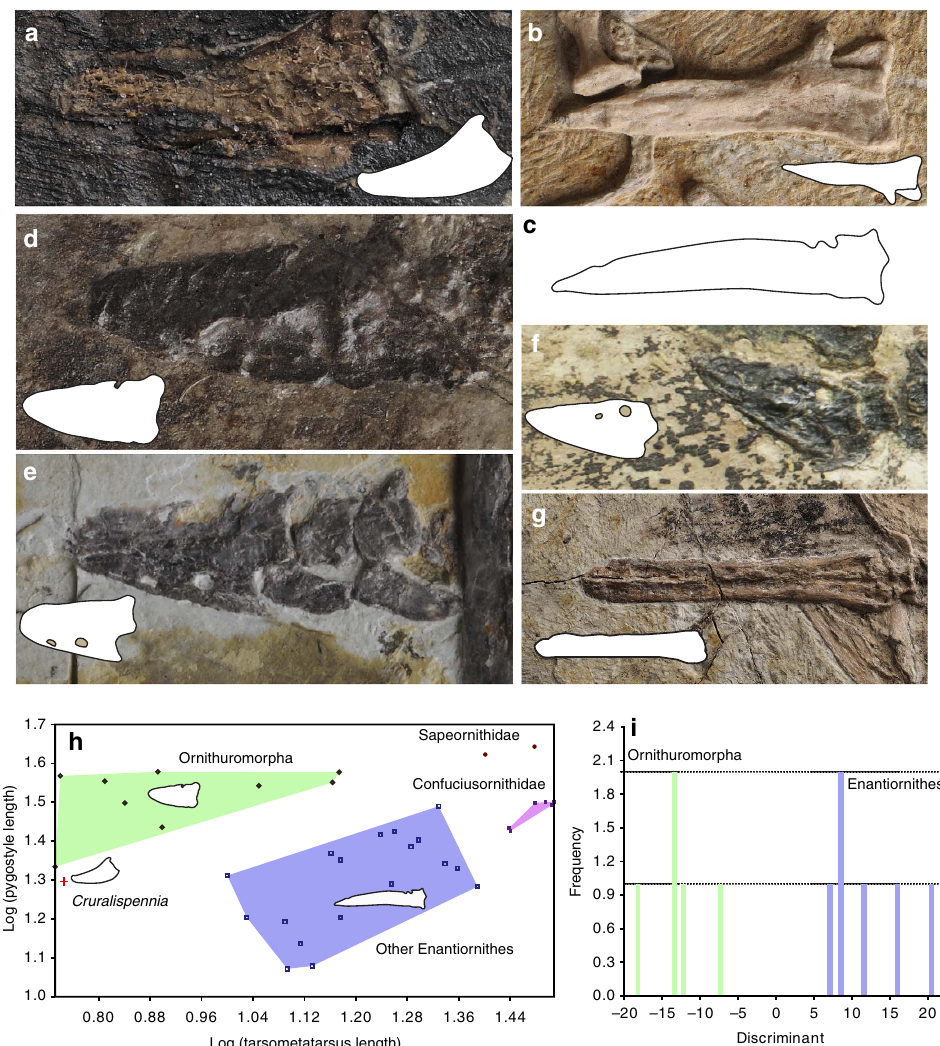
Figure 3 | Pygostyle of C. multidonta in comparison with other basal birds. ( a – e ) photographs and line drawings of the pygostyle in lateral view: ( a ) Cruralispennia ; ( b ) enantiornithine Pterygornis ; ( c ) enantiornithine Concornis ; ( d ) ornithuromorph Yixianornis ; ( e ) ornithuromorph Bellulornis ; ( f ) ornithuromorph Piscivoravis ; ( g ) basal pygostylian Confuciusornis . ( h ) Pygostyle length (y-axis) plotted against tarsometatarsal length ( x axis) to compare the relative length of the pygostyle between groups of Mesozoic birds, showing that the highly abbreviated pygostyle of Cruralispennia is distinct from other enantiornithines but comparable to that of the Ornithuromorpha. ( i ) Results of discriminant analysis as histogram showing the Enantiornithes and basal ornithuromorphs plotted along the axis that maximizes their pygostyle differences; the obtained discriminant function suggest that the pygostyle of Cruralispennia falls within the morphospace of the